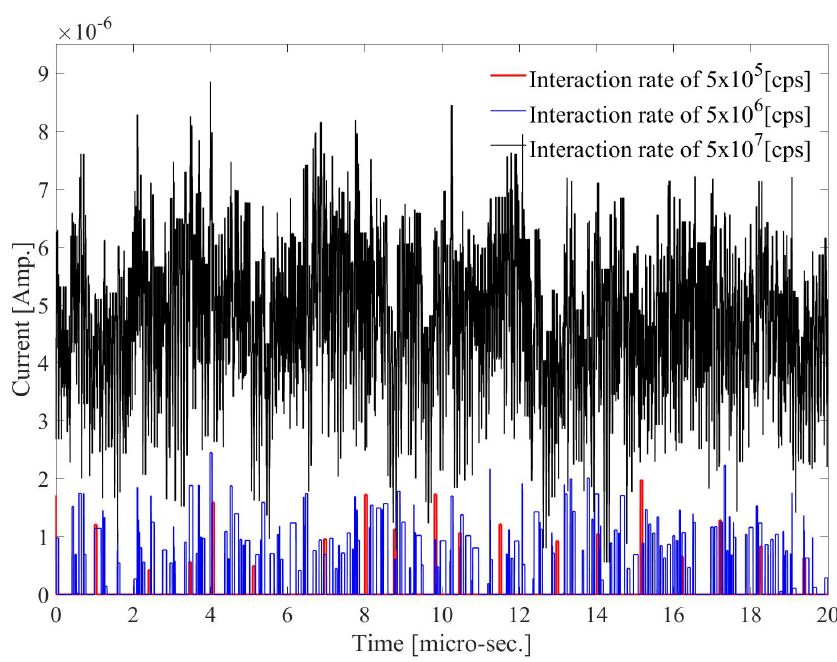
Figure 4. Simulated detector signals at 5 × 10 5 , 5 × 10 6 , and 5 × 10 7 [events /